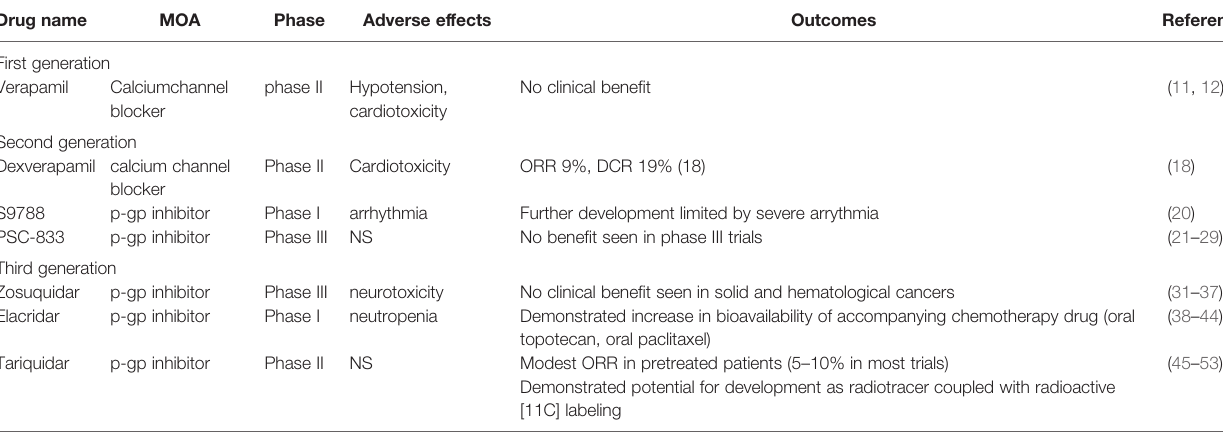
TABLE 2 | Summary of major pg-1 inhibitors in clinical development.